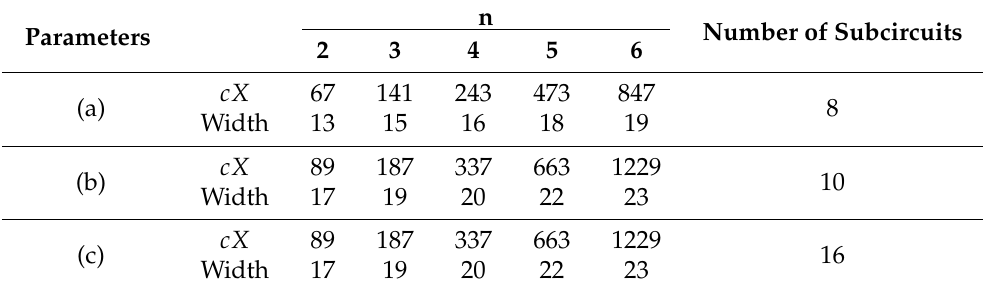
Table 1. Required cX -gate counts and circuit width (number of used qubits) for a single subcircuit and number of subcircuits used in the presented algorithm with parameters (a) D = 1, n f =